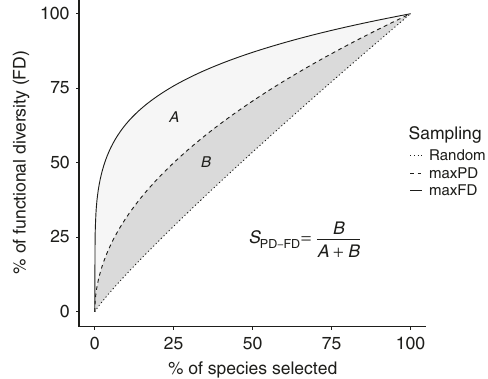
Fig. 1 A conceptual approach for evaluating whether PD is a good surrogate for FD. To evaluate if PD is a good surrogate of FD, we measure to what extent a species prioritization strategy that maximize PD captures FD relative to an optimal and a random strategy. To do so, we compare FD accumulation curves (i.e., FD computed for increasing proportion of the species pool considered) across these three different sampling strategies: the random sampling (i.e., rarefaction curve, averaged over 1000 sets), the maxPD sampling, and the maxFD (optimal) sampling (i.e., sets that maximize FD, see legend). Then, we measure the surrogacy of PD for FD ( S PD – FD ) as the area between the random and the maxPD curve ( “ A ” , see legend) divided by the area between the random and the maxFD curve ( “ A + B ” , see legend). If S PD – FD is positive, PD is a good surrogate for FD (the maximum value being 1 where PD is an optimal surrogate) while when S PD – FD is negative preserving species based on PD is worse than